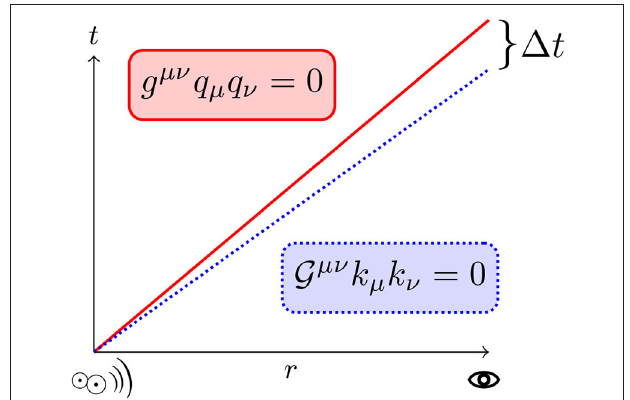
FIGURE 11 | Anomalous GW speed. Gravitational waves propagate on an effective metric G µν (blue) with a different causal structure than the physical ω ( E k ) / |E k metric g µν (red) (Bettoni et al., 2017). The speed is derived as c g ( E k ) = | where k µ ( ω , E k ) is the solution to G µν k µ k ν 0. Note that the speed can = = depend on the propagation direction. It may also depend on the frequency (e.g., massive graviton or Lorentz violation), cf.